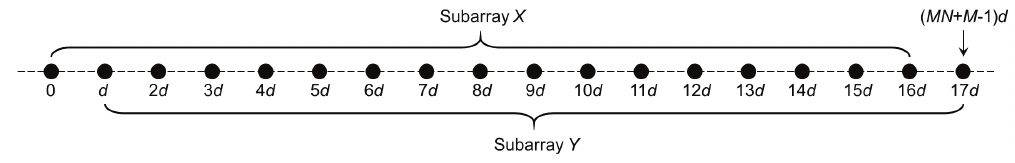
Figure 3. The pair of subarrays S X and S Y extracted from the coprime coarray, M = 3 and N =